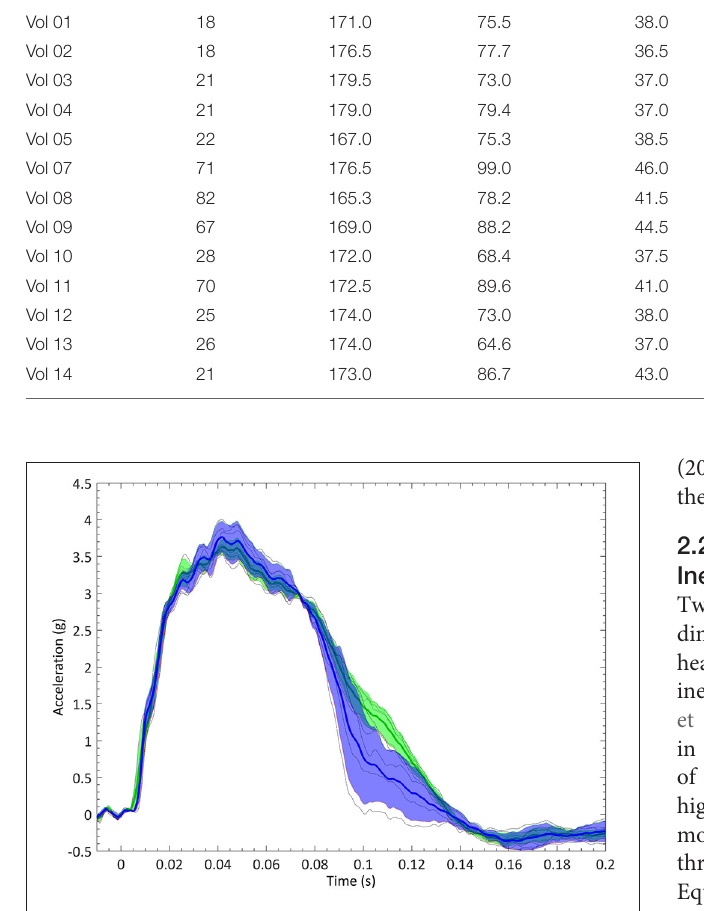
FIGURE 1 | Sled deceleration pulse corridors in the young (blue) and elderly (green) groups. Solid lines are the average deceleration within the group. Shaded area corresponds to the one standard deviation corridor.